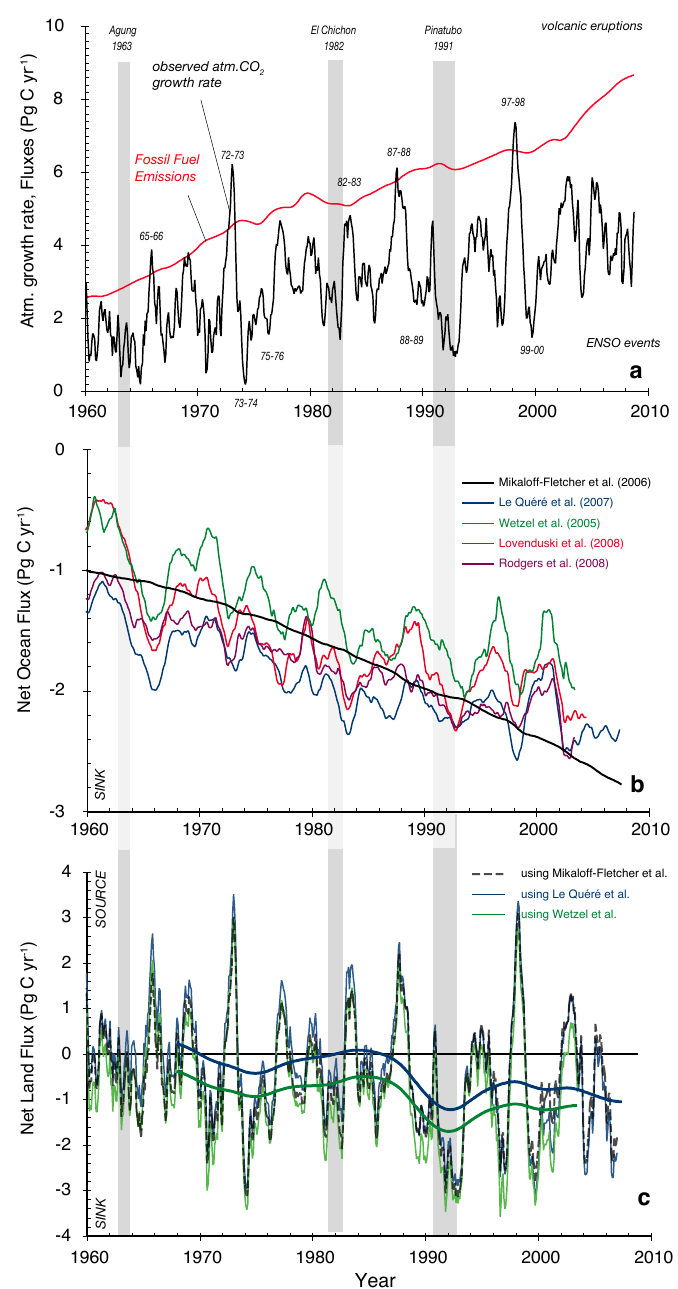
Fig. 1. Monthly deseasonalized carbon fluxes in PgCyr − 1 . (a) Fossil fuel emissions and annual atmospheric growth rate calculated with Mauna Loa data (see Appendix A for data sources and methods). Major volcanic eruptions and ENSO events are identified by their dates. (b) Net atmosphere-ocean fluxes of CO 2 as simulated by ocean models. The solid black line labeled Mikaloff Fletcher et al. (2006) represents the expected temporal evolution of the ocean uptake if there is no change in ocean circulation and transport. By construction, this goes through our best data and model based estimates of ocean CO 2 uptake of ∼ 2.2 ± 0.2PgCyr − 1 for the 1990s and early 2000s (cf. Gruber et al., 2009). The Le Qu´er´e et al. (2007), Lovenduski et al. (2008), Rodgers et al. (2008) and Wetzel et al. (2005) results are from ocean “hindcast” simulations, where an ocean carbon cycle model is forced with re-analyzed variations of wind, and freshwater and heat fluxes over the last few decades. The Le Qu´er´e et al., Rodgers et al., and the Lovenduski et al. simulations all overlap the Mikaloff Fletcher et al. result during the 1990s. The Wetzel et al. ocean carbon sink estimate is somewhat on the low side, though its behavior in time, which is the aspect of these models that we emphasize in the discussion, is similar to that of the others. (c) Net atmosphere-land fluxes of CO 2 estimated by subtracting three model estimates of the ocean sink from panel (b) and the atmospheric CO 2 growth rate from panel (a) from the fossil fuel emissions shown in panel (a). The smooth lines are from a Butterworth filter with a five year smoothing time